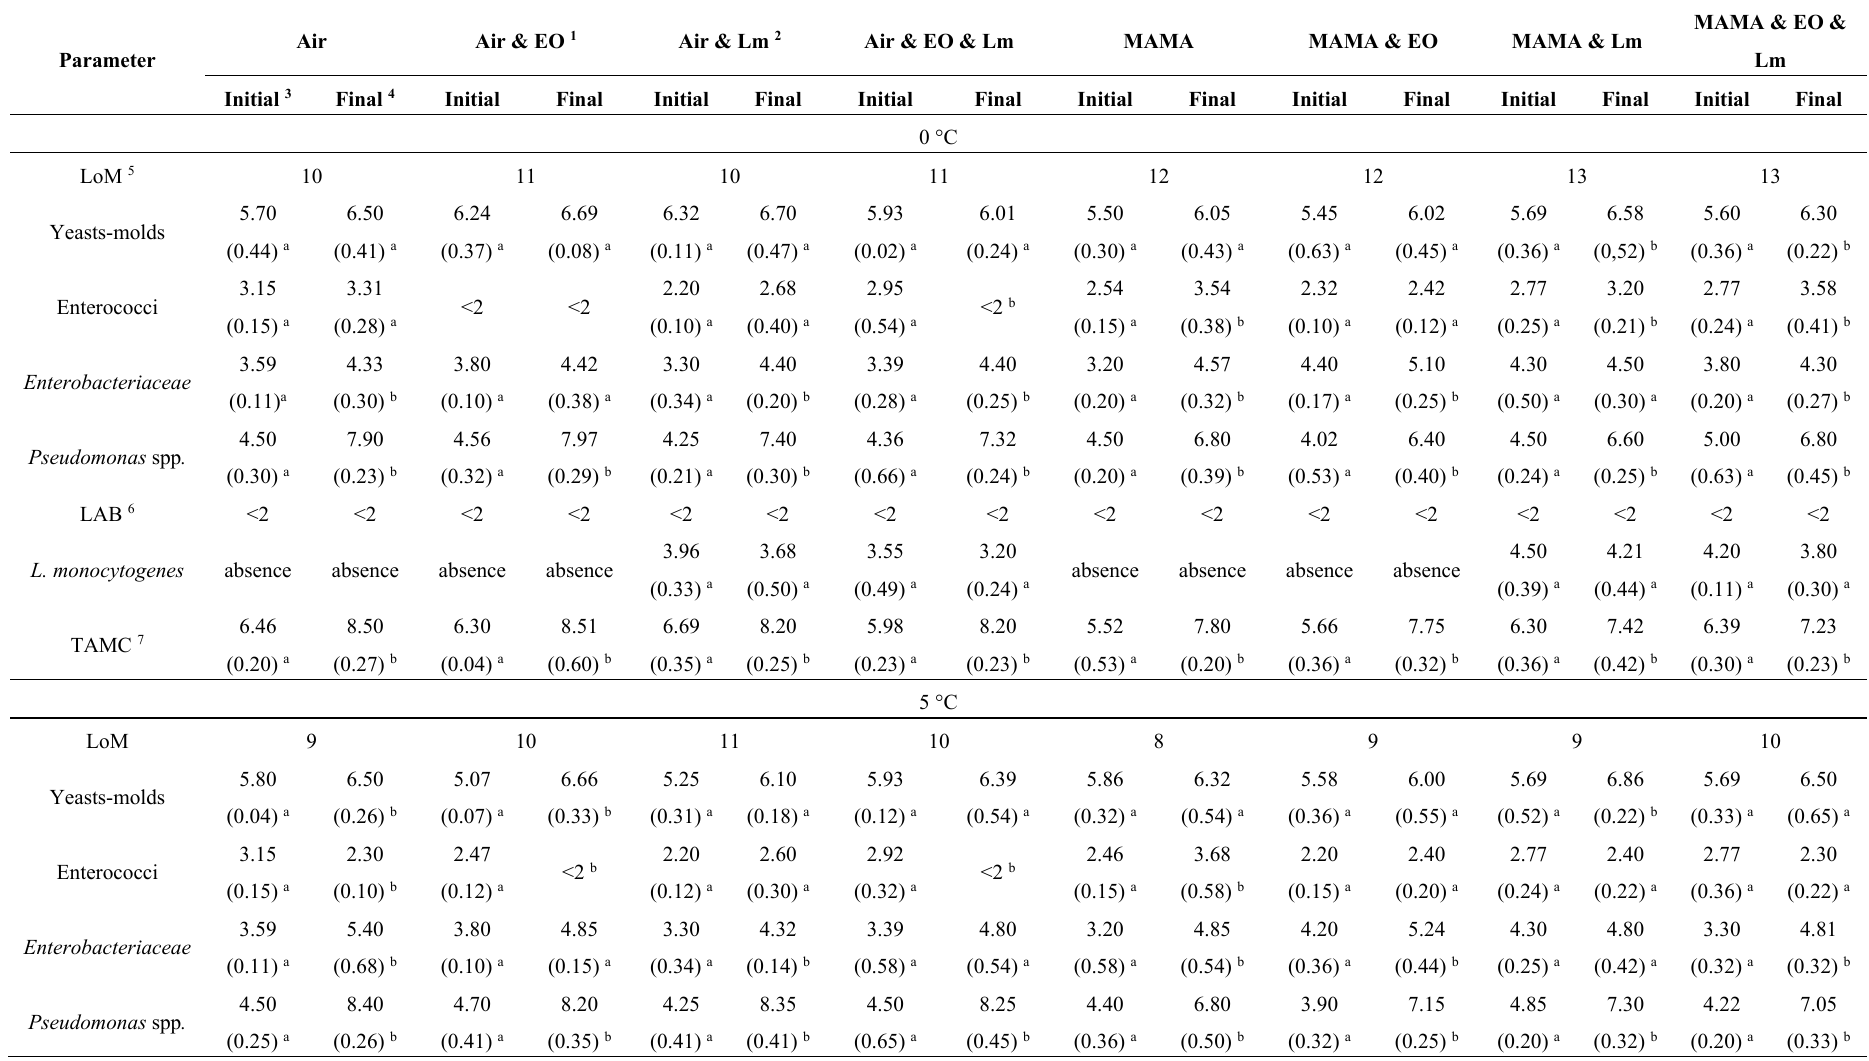
Table 1. Limit of marketability (days) and microbial population dynamics (log CFU g −1 ) during incubation of rocket at 0, 5, 10, and 15°C packaged in air or MAMA conditions, with or without lemongrass essential oil, with or without inoculation with L. monocytogenes . Air Parameter